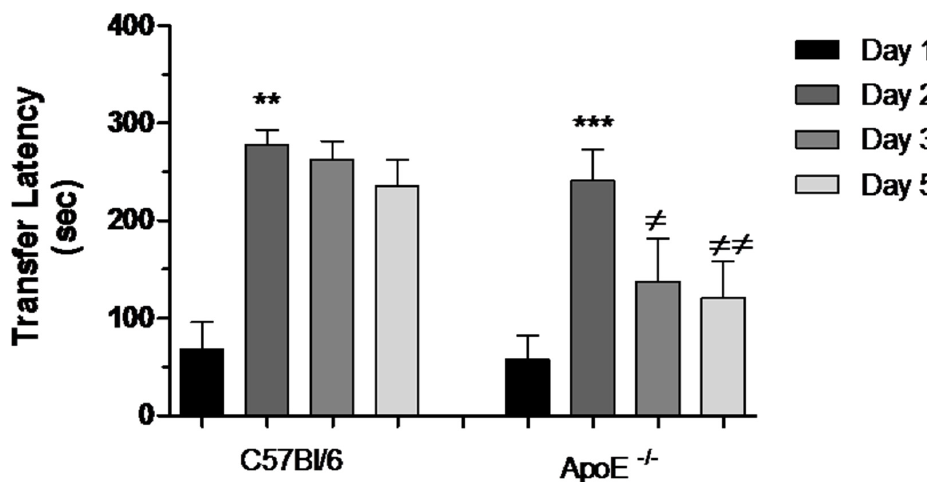
Figure 6. Reduction of transfer latency between Days 2, 3 and 5 in female ApoE − / − mice. Transfer latency to entering the dark compartment was measured on Days 1, 2, 3 and 5 in C57Bl/6 and ApoE − / − mice. Values are expressed as means ± SEM. Transfer latency increased significantly on Day 2 in both strains: C57Bl/6 (n = 6) and ApoE − / − mice (n = 10) (** p < 0.01 and *** p < 0.001, respectively, Mann Whitney Test). However, significant difference was found between Days 2, 3 and 5 exclusively in ApoE − / − mice ( ≠ p < 0.05; ≠≠ p < 0.001, F(2/29) = 6.236, p = 0.0005. Repeated measured ANOVA and Bonferroni’s Multiple Comparison Test).